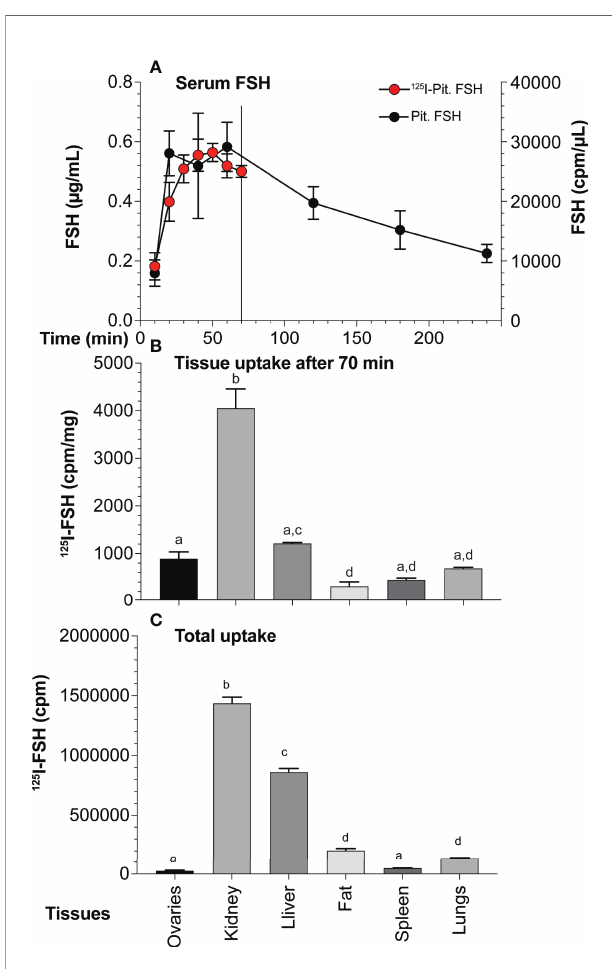
FIGURE 10 | Pituitary FSH uptake and tissue accumulation. (A) FSH appearance and clearance from mouse serum following IP injection of 10 µg unlabeled pituitary FSH over 6 hr (solid circles, mean ± SD, n = 5) or 5 ng 125 I-pituitary FSH over 70 min (red circles, mean ± SD, n = 3). The points are mean values of three mice The line indicates 70 min point at which mice were euthanized for tissue recovery. (B) Normalized tissue uptake of 125 I-pituitary FSH 70 min following IP injection of 1 µg pituitary FSH tracer. Signi fi cant differences (p < 0.05) indicated by different letters; a ovaries, b kidney, c liver, and d fat. (C) Total 125 I-FSH uptake in each tissue showing impact of size.